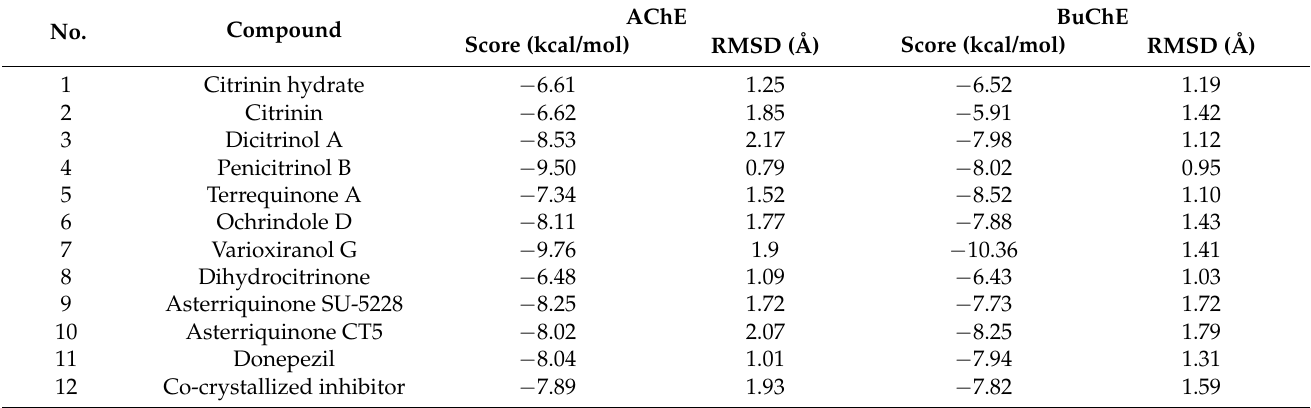
Table 3. The docking scores and RMSD values for the most promising ten candidates from A. niveus Fv-er401 within the binding sites of both AChE and BuChE receptors. Also, donepezil and the co-crystallized inhibitors are depicted as reference standards.